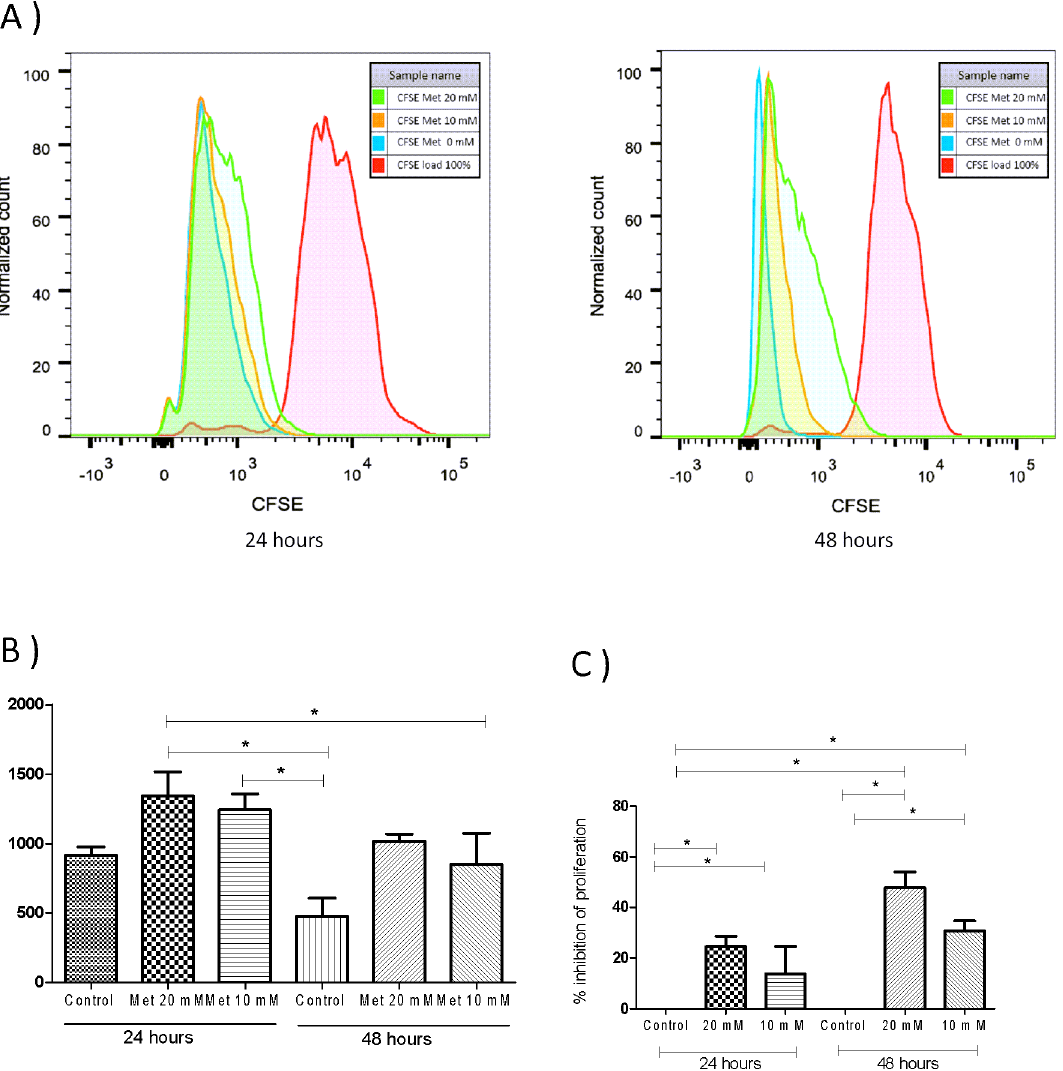
Fig 2. Metformin induced inhibition of HaCaT cells proliferation. Human HaCaT cells were cultured 24 hours before CFSE labeling in FBS 1% to synchronize the culture cell cycle. Labeling was performed with CFSE as described in the methods section. After that the cells were cultured for 24 hours to adherence and then treated with 0 mM (PBS), 10 mM and 20 mM of metformin for 24 or 48 hours. The proliferation in HaCaT cells was assessed by flow cytometry. (A) Histograms show cell proliferation inhibition at 10 mM and 20 mM, the effect is observed after 24 hours of treatment. (B) The graph shows the mean fluorescence intensity of cells labeled with CFSE, it is clear that cells were treated with metformin have a higher intensity of fluorescence due to decreased cell proliferation. (C) Percentage of inhibition of proliferation is shown compared to control treated cells. Inhibition is observed in both the 10mM and 20 mM metformin treated cells and dependence on time is also